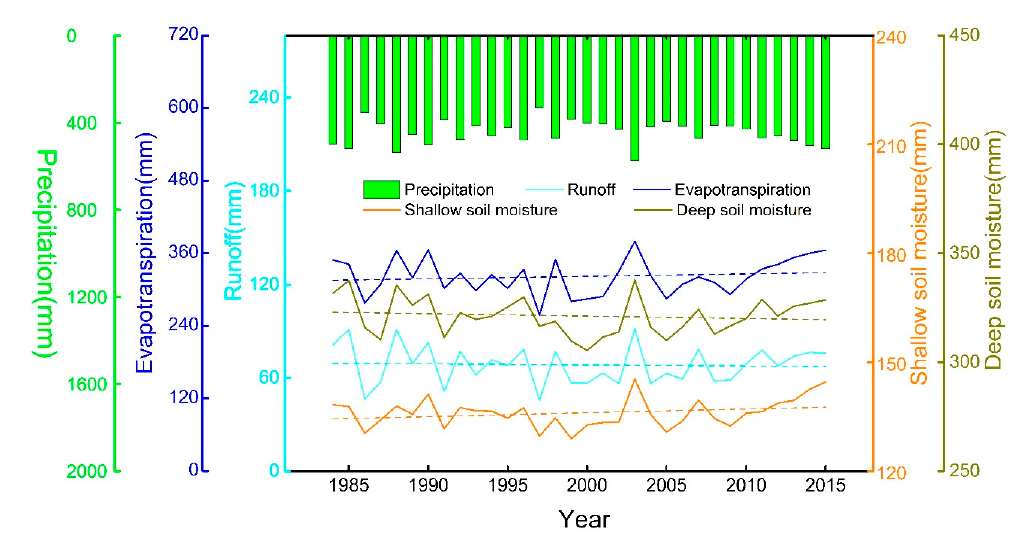
Figure 7. Temporal variations of runoff (Runoff), evapotranspiration (ET), shallow soil moisture (SM1) and deep soil moisture (SM2) for the CM from the years 1984 to 2015.